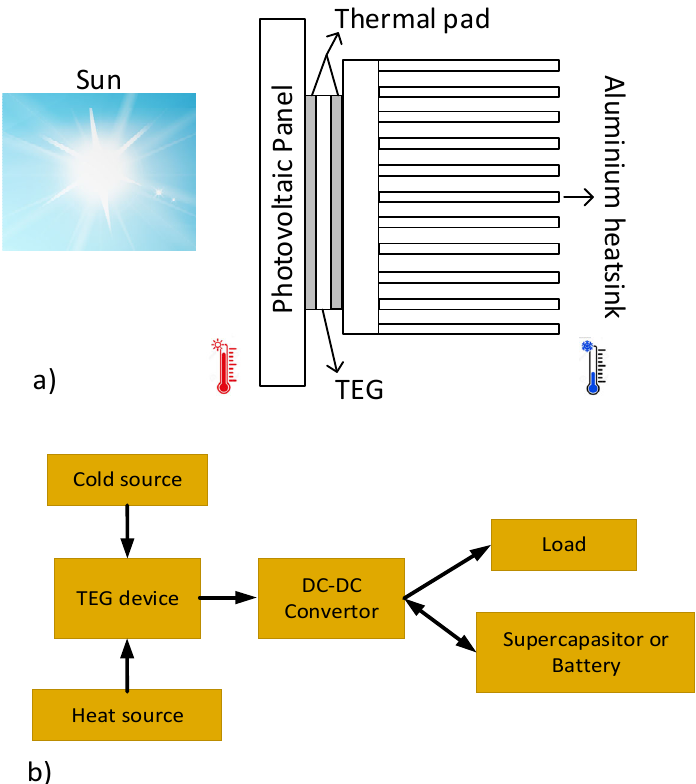
Figure 4. ( a ) Schematic diagram and ( b ) block diagram of the thermoelectric-energy-harvesting prototype photovoltaic panel.